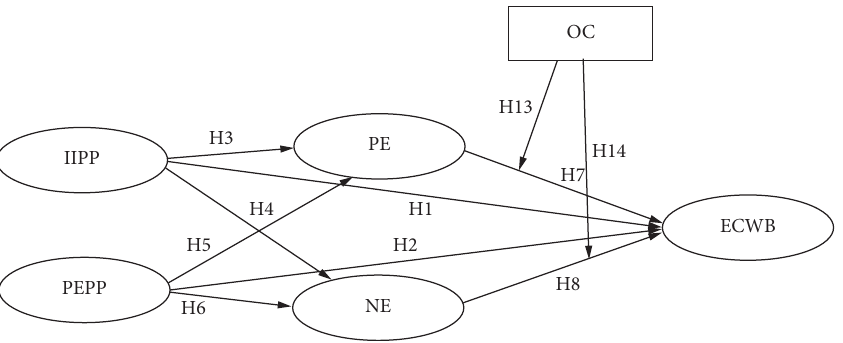
Figure 1: The conceptual framework